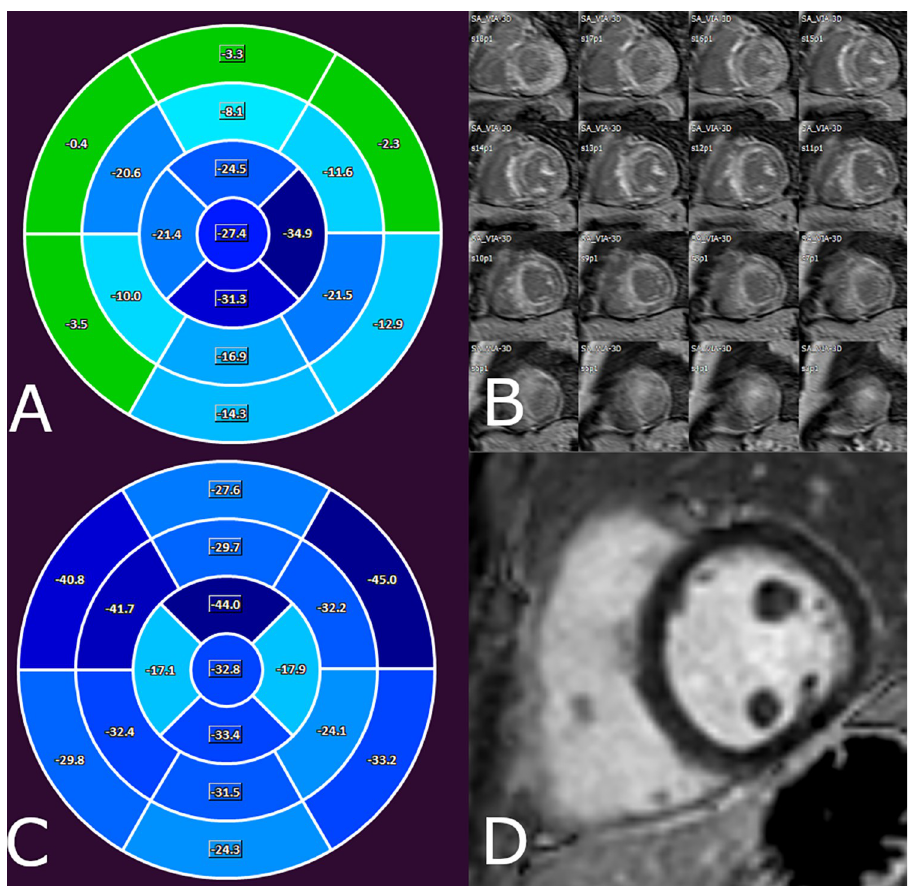
Fig 2. Bull’s eye with segmental LS values (A, C) and late enhancement images in short-axis slices (B, D) of a patient with cardiac amyloidosis (A, B) and of a person without structural heart diseases (C, D).